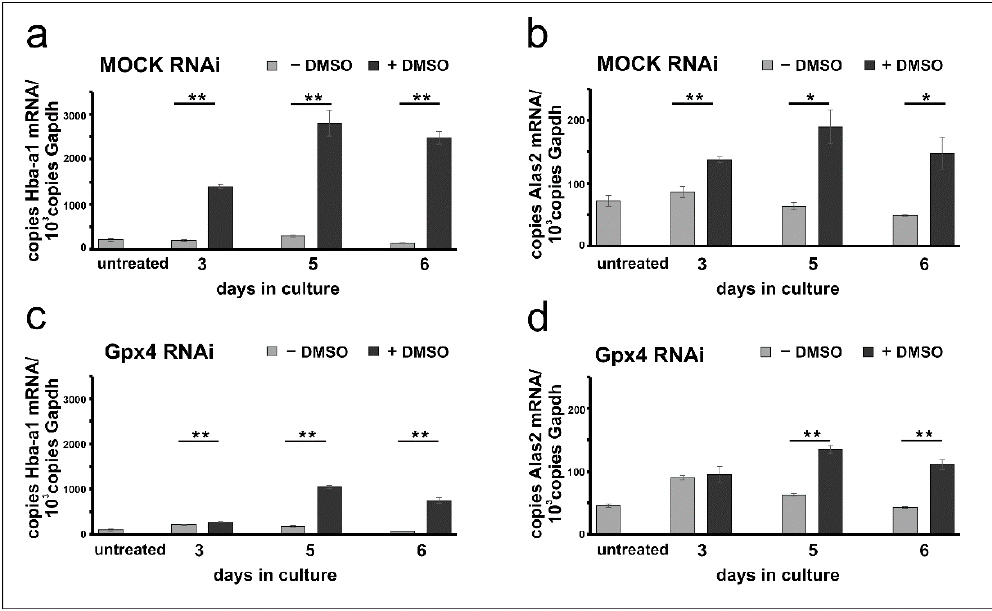
Figure 3. DMSO induces erythroid differentiation in mock-transfected and Gpx4 siRNA transfected MEL cells. Total RNA was extracted from untreated and DMSO-treated MEL cell transfectants at different days of the culture period. The steady- state concentrations of Hba-a1, Alas2, and Gapdh mRNAs were quantified by qRT-PCR using the specified amplification primers as described in the Material and Methods section. Each sample was quantified in triplicates. ( a ) Expression of Hba-a1 mRNA in MOCK RNAi MEL cells. ( b ) Expression of Alas2 mRNA in MOCK RNAi MEL cells. ( c ) Expression of Hba-a1 mRNA in Gpx4 RNAi MEL cells. ( d ) Expression of Alas2 mRNA in Gpx4 RNAi MEL cells. Significances were calculated using the Student’s t -test, * p < 0.05, ** p < 0.005.